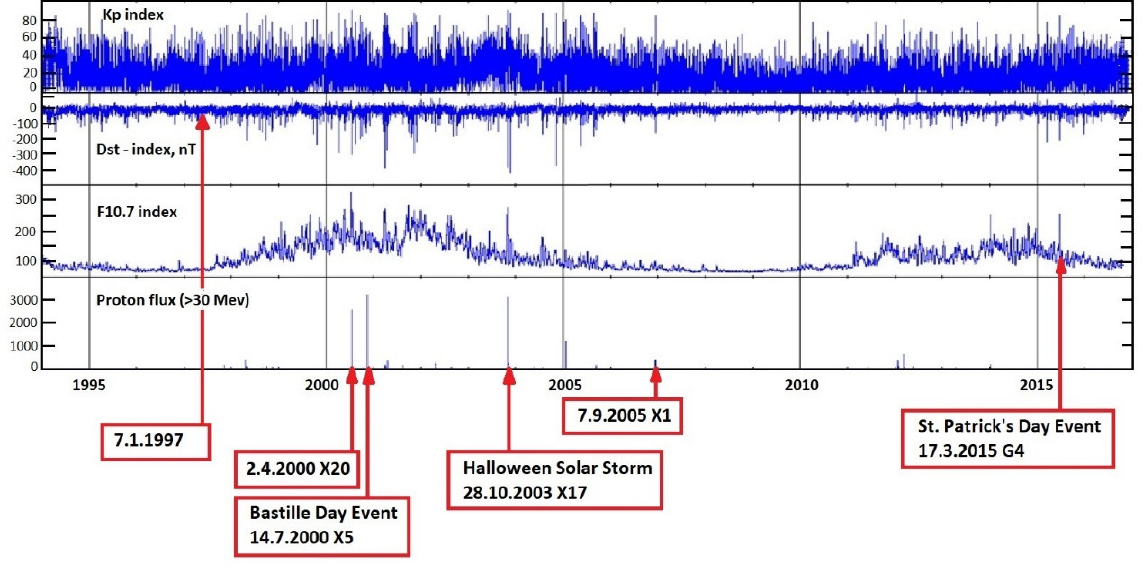
Figure 1. Solar activity variability during the investigated period from years 1994 to 2015 belonging to the Solar Cycles No. 23 and No. 24.